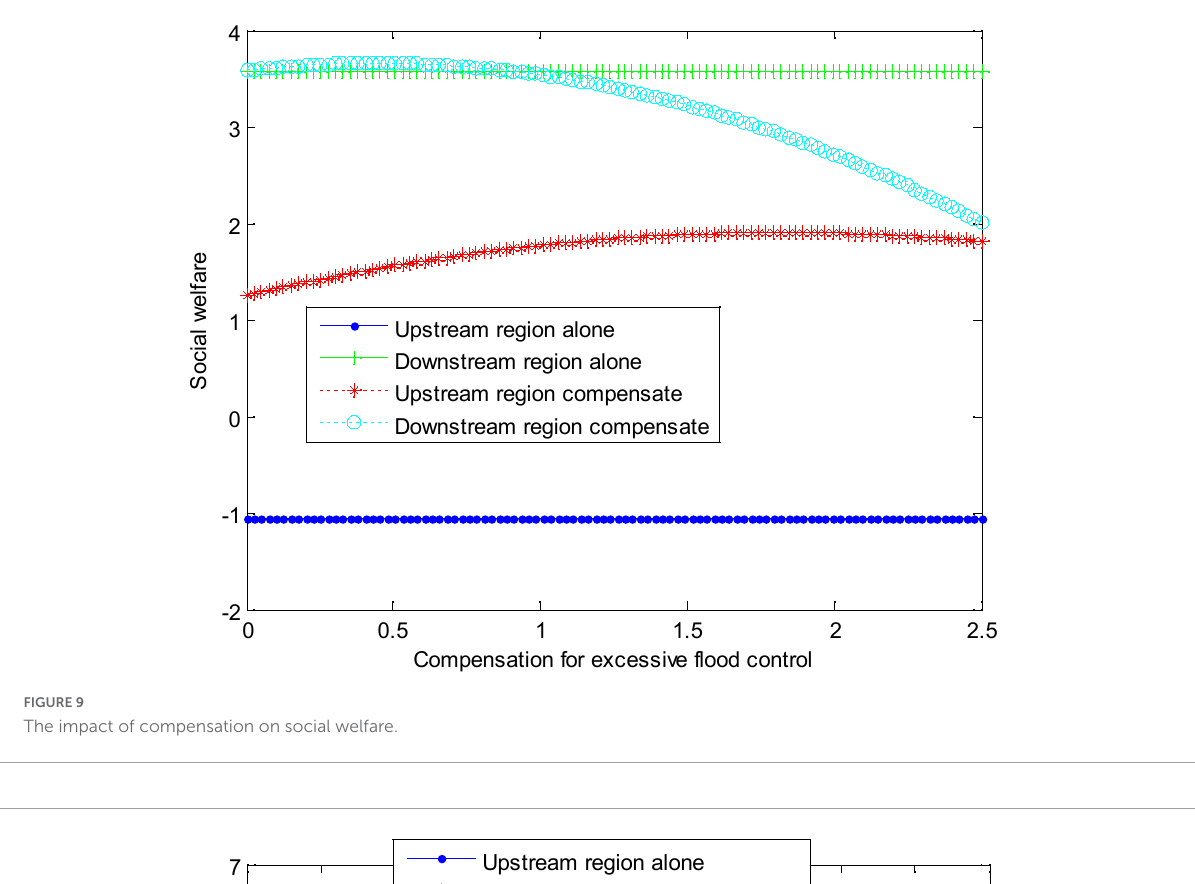
FIGURE9 The impact of compensation on social welfare.